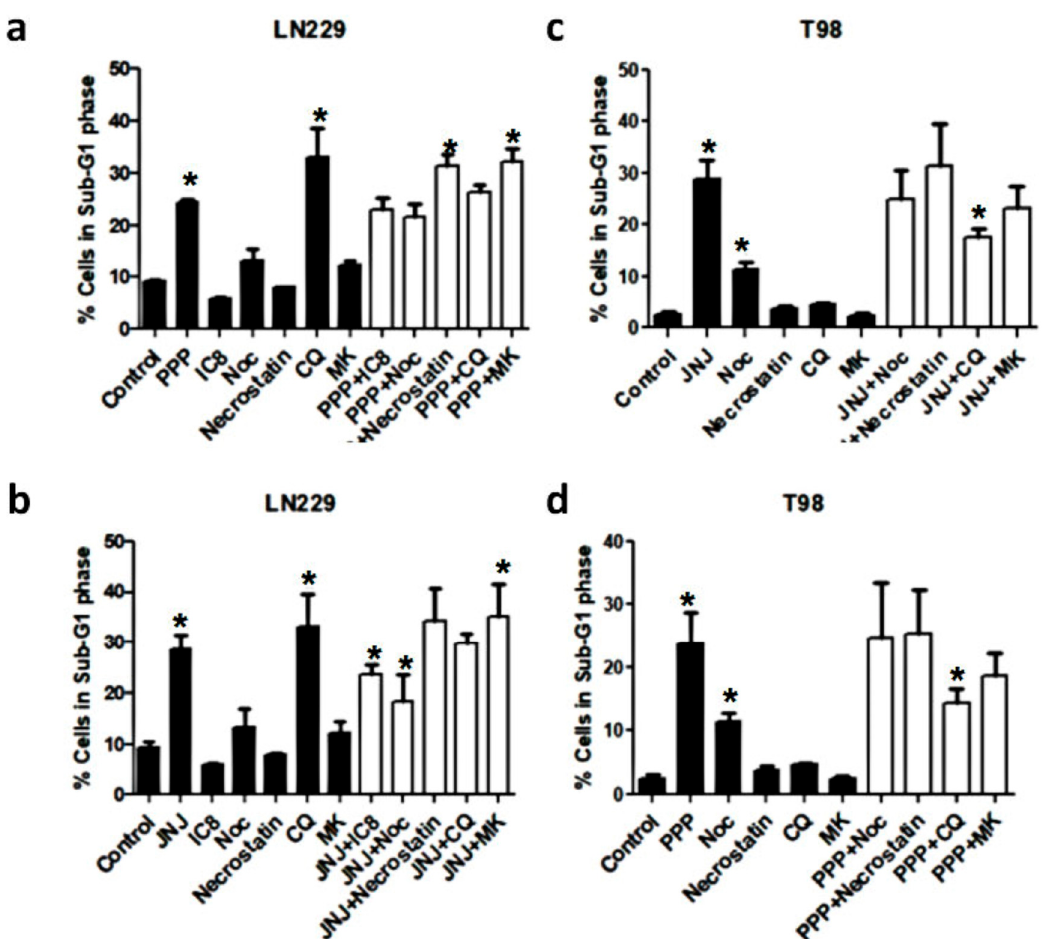
Figure 6. Role of other inhibitors in JNJ and PPP-induced cell death. ( a , b ) LN-229 cells were treated with DMSO (Control), 500 nM JNJ or 500 nM PPP in the presence or absence of 25 µ M of the specific caspase-8 inhibitor Ac-IETD-CHO (IC8), 1 µ g/mL Nocodazole (Noc), 10 µ M Necrostatin-1, 20 µ M chloroquine (CQ), or 100 nM MK-1775 for 24 h, after a 30 min pretreatment with these inhibitors. ( c , d ) T98 cells were treated with DMSO (Control), 500 nM JNJ or 500 nM PPP in the presence or absence of 1 µ g/mL Nocodazole (Noc), 10 µ M Necrostatin-1, 20 µ M chloroquine (CQ), or 100 nM MK-1775 for 24 h, after a 30 min pretreatment with these inhibitors. Then, cells were subjected to cell cycle analyses, as described in Materials and Methods. The percentage of cells in the SubG 1 phase is represented as the average of more than three independent experiments. Black bars represent treatments as single agents. White bars represent combination of treatments. Error bars are the S.E.M. ( n = 16; control, PPP or JNJ treatment are the conditions present in 16 independent experiments, all the other conditions were assayed in at least six of the total 16 experiments). * Means a statistically significative change in PPP or JNJ treated cells (white filled bars), as compared to the control untreated cells (black filled bars), p < 0.05.